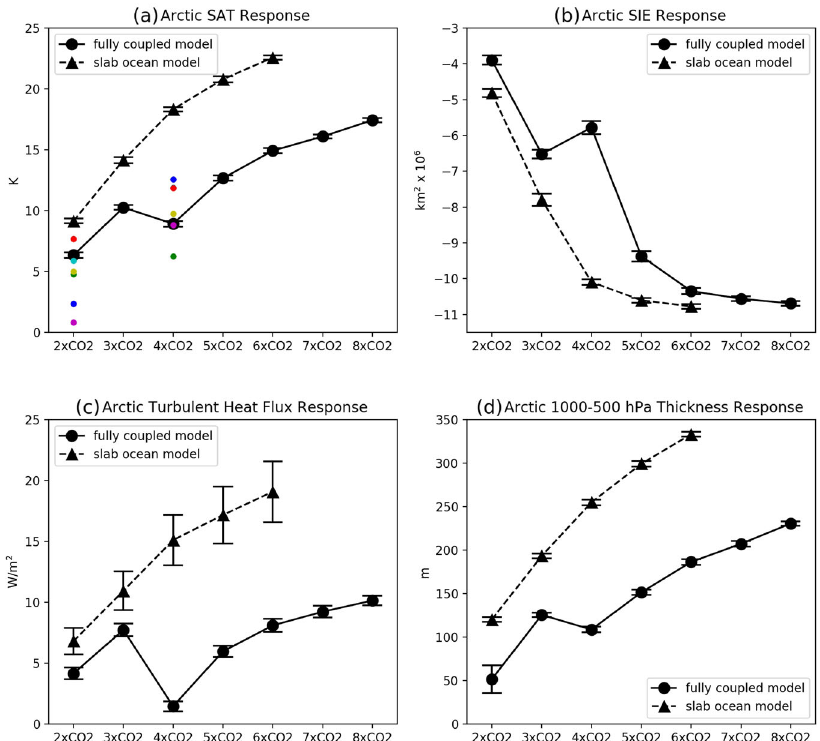
Fig. 1 Annual-mean Arctic surface and tropospheric response as a function of CO 2 forcing in fully coupled and slab ocean model experiments. a Surface air temperature (SAT) response. The colored dots are the 2× and 4 × CO 2 experiments from six CMIP6 models: CESM2 (blue), CNRM-CM6-1 (cyan), GISS-E2-1-G (green), MIROC6 (yellow), MRI-ESM2-0 (magenta), TaiESM1 (red). b Sea-ice extent (SIE) response. c Turbulent heat fl ux (latent plus sensible heat components) response (positive value means heat fl uxes from ocean to atmosphere). d 1000 – 500 hPa thickness (geopotential height difference between 1000 hPa and 500 hPa) response. The solid line with circle symbols represents responses for the fully coupled model experiments, whereas the dashed line with triangle symbols for the slab ocean model experiments. Error bars denote 95% con fi dence intervals calculated using Student ’ s t